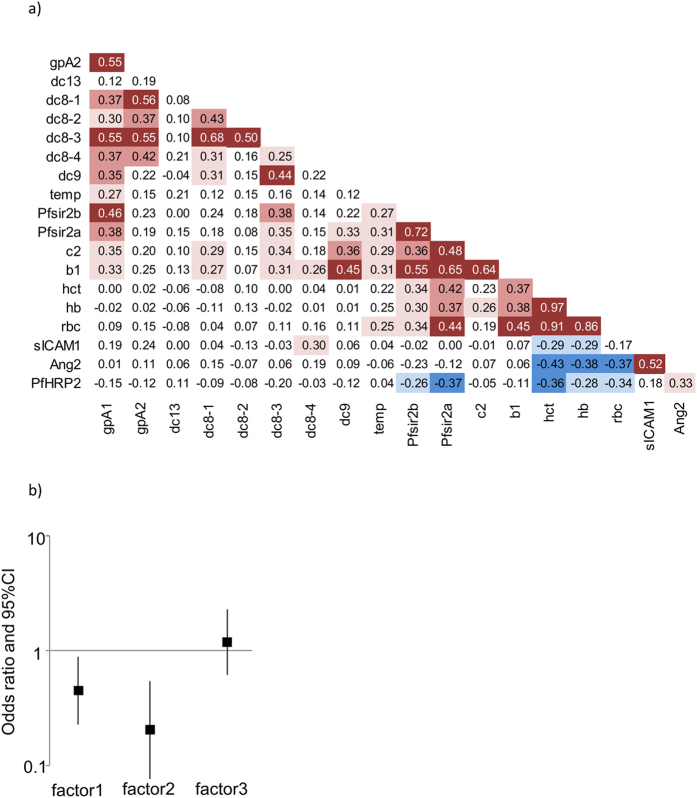
Correlation matrix and Principal factor analysis.(a) A correlation matrix: Shown are Spearman’s correlation coefficients of the associations between the variables (N = 62). The background shading is based on the p value of the associations. The darker the background colors the smaller the p value ; dark red = p < 0.0005, mid red = p < 0.005 - ≥ 0.0005, light red = p < 0.05 - ≥ 0.005. mid blue = p < 0.005 - ≥ 0.0005, light blue = p < 0.05 - ≥ 0.005. Red background indicates positive associations and blue background indicate negative associations. (b) The relationship between factor scores derived from principal factor analysis and retinopathy: A plot of odds ratio and 95% CI of three logistic regression models predicting retinopathy using either factor 1 factor 2 or factor 3 scores as sole explanatory variables. More details of these factors are shown in Table 2.